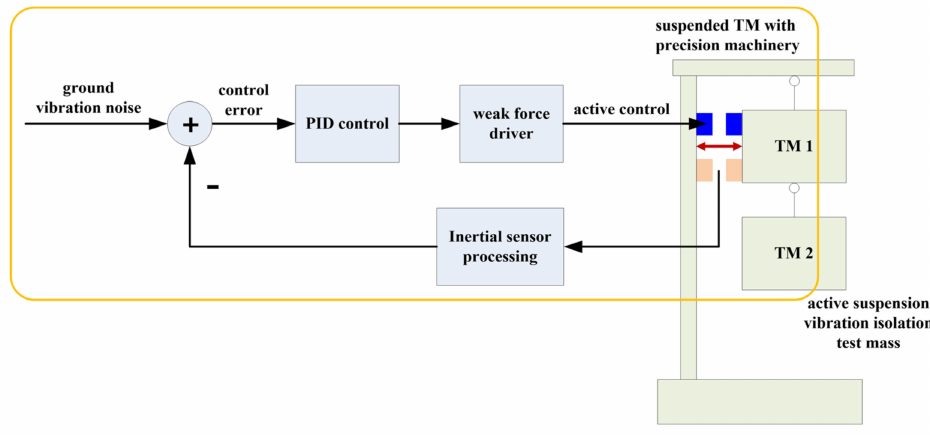
Figure 9. Schematic diagram and block diagram of active suspension vibration isolation.